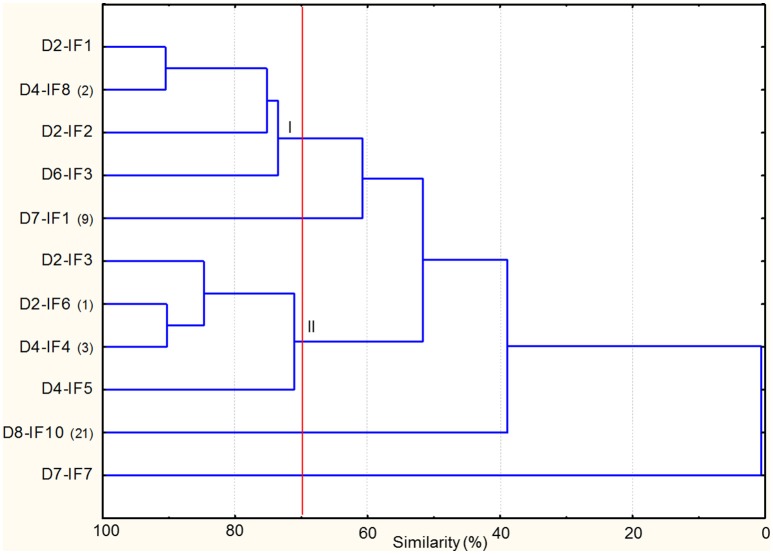
Dendrogram of combined (primers M13m and RP11) RAPD profiles of Saccharomyces cerevisiae strains isolated from the mature sourdoughs prepared with irradiated durum wheat flour (IF). The alphanumeric code (D2-IF, D4-IF, D6-IF, D7-IF, D8-IF) of the strain name indicates the sourdough of origin. Where present, the numbers in brackets at right of the strain name indicates the number of isolates showing the same RAPD profile. Cluster analysis was based on UPGMA algorithm. Clusters are indicated by Roman numerals (I–II).